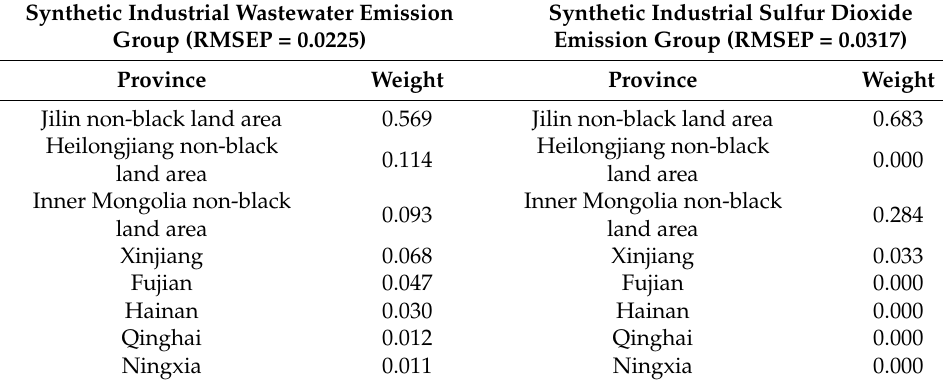
Table 2. Weights of two groups of black land areas of synthetic industrial pollution emissions. Synthetic Industrial Wastewater Emission Synthetic Industrial Sulfur Dioxide Group (RMSEP = 0.0225) Emission Group (RMSEP = 0.0317)